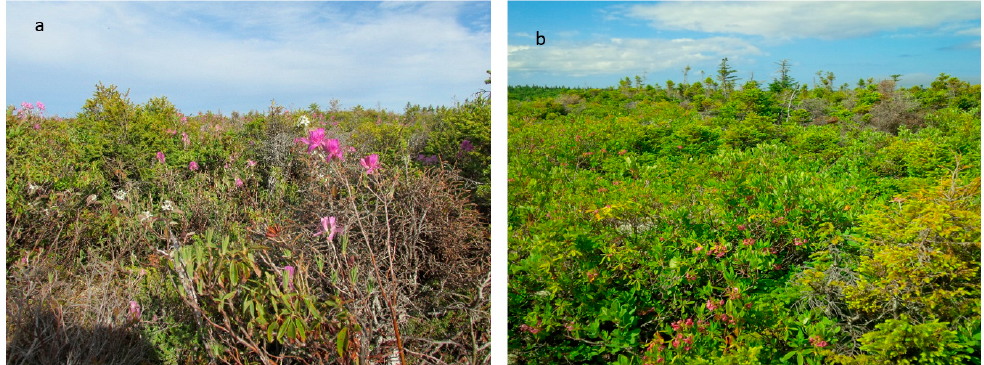
Figure 4. Picture of fuel Nova Scotia Special Fuel Type (NS-1) on ( a ) June 12 2014 ( b ) July 15